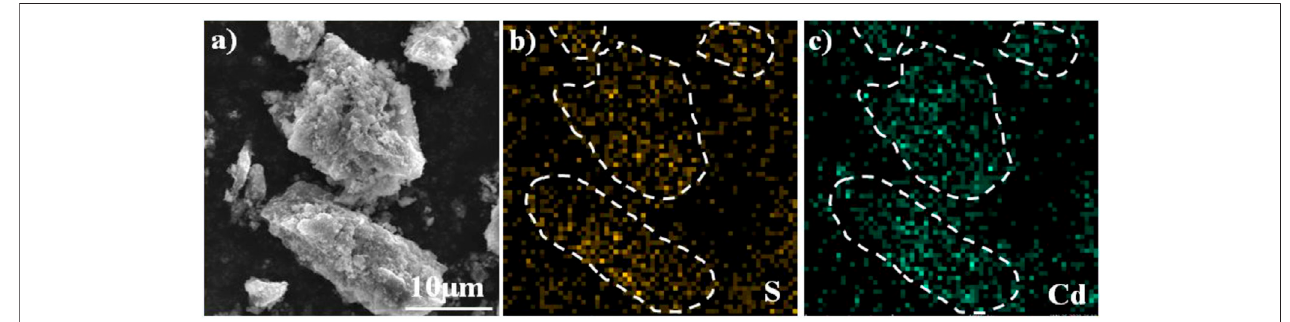
FIGURE 1 | SEM images of (A) CdS@CP, surface energy spectrum scan of (B) S and (C)